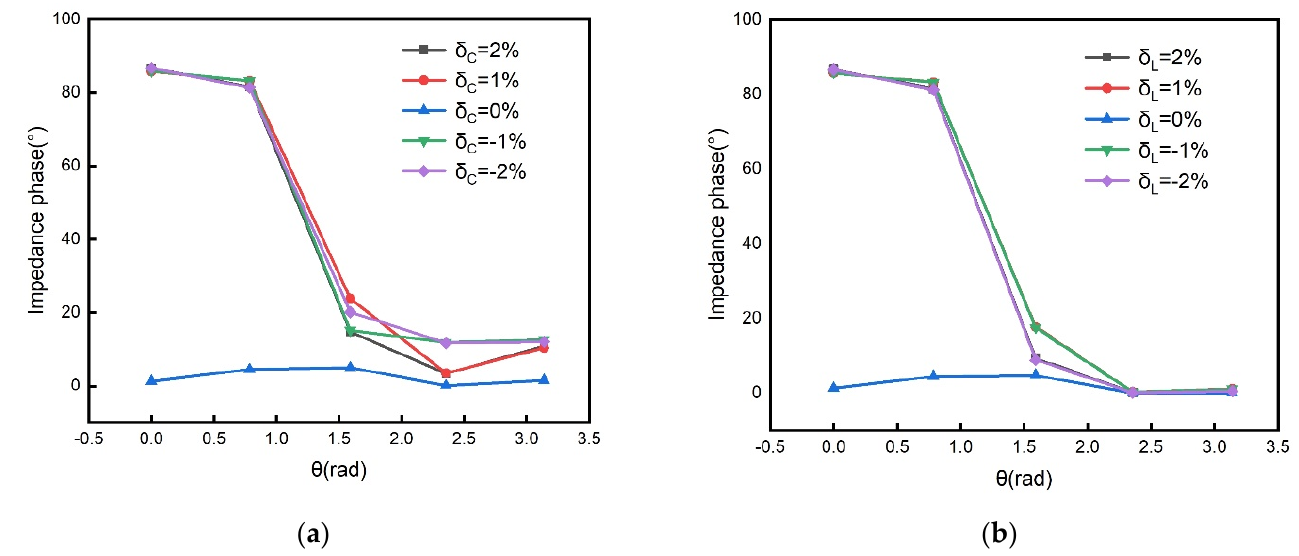
Figure 4. The amplitude of impedance as a function of rotation angle under different coupling distances.